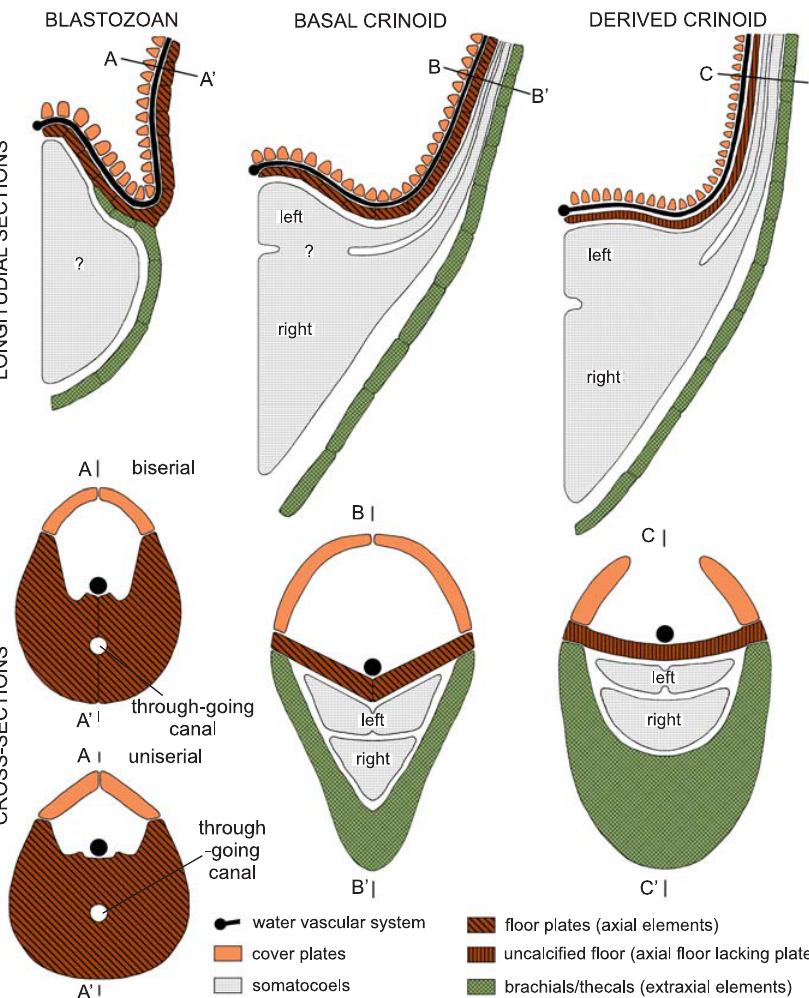
left.Fig. 6. Colorized schematic cross sections illustrating fundamental differences separating crinoids and blastozoans, tube feet not illustrated (modified from Guensburg et al.